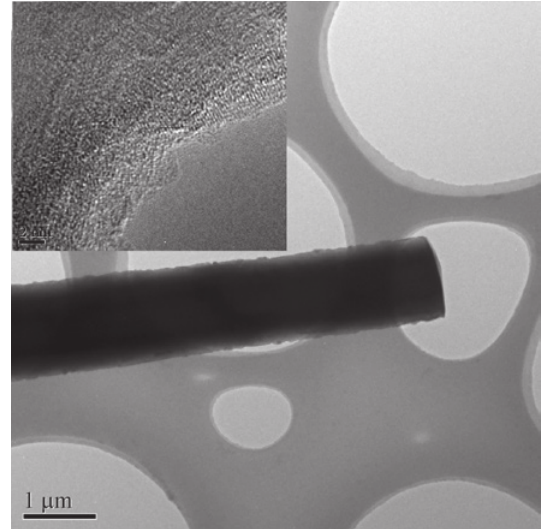
Fig. 7: TEM and HRTEM images of the synthesized AlN whiskers